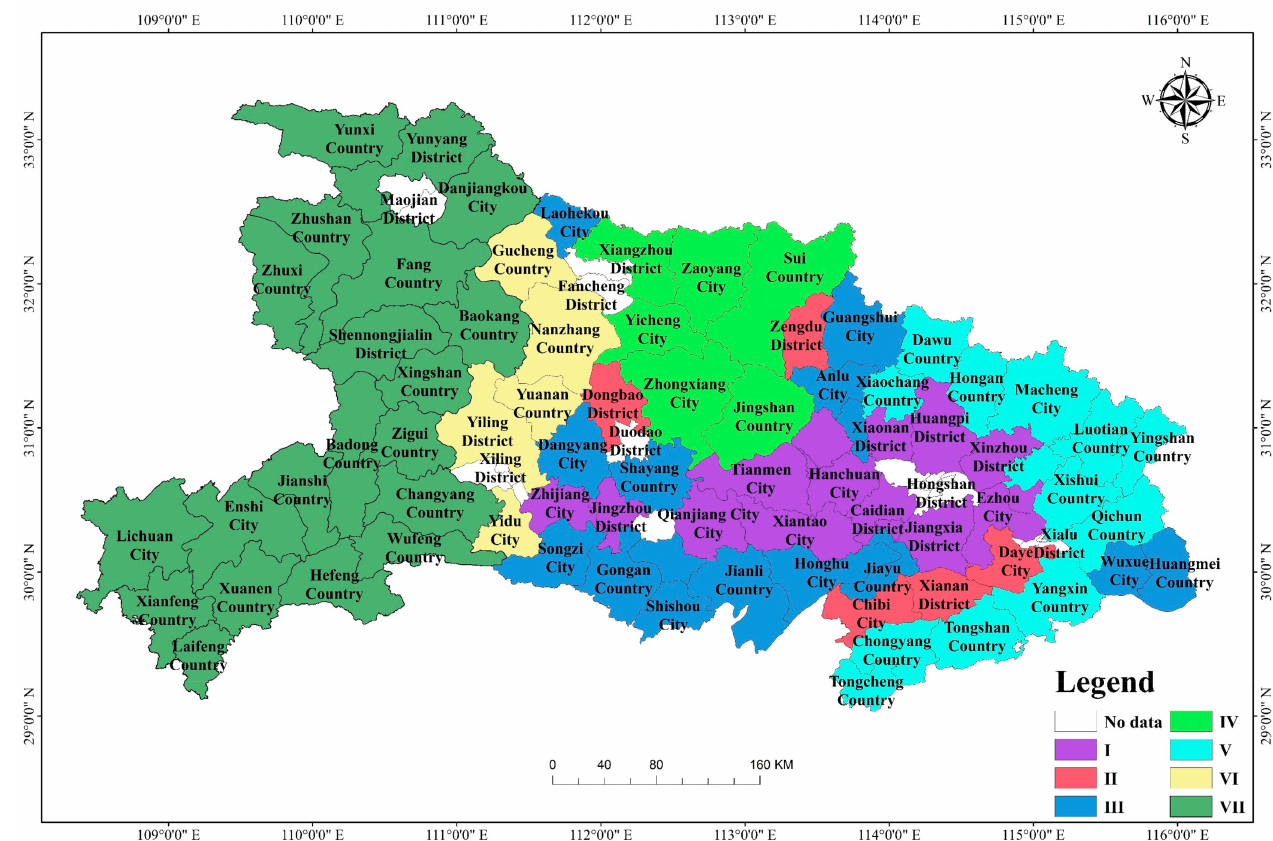
Figure 8. Map of land consolidation zoning scheme in Hubei